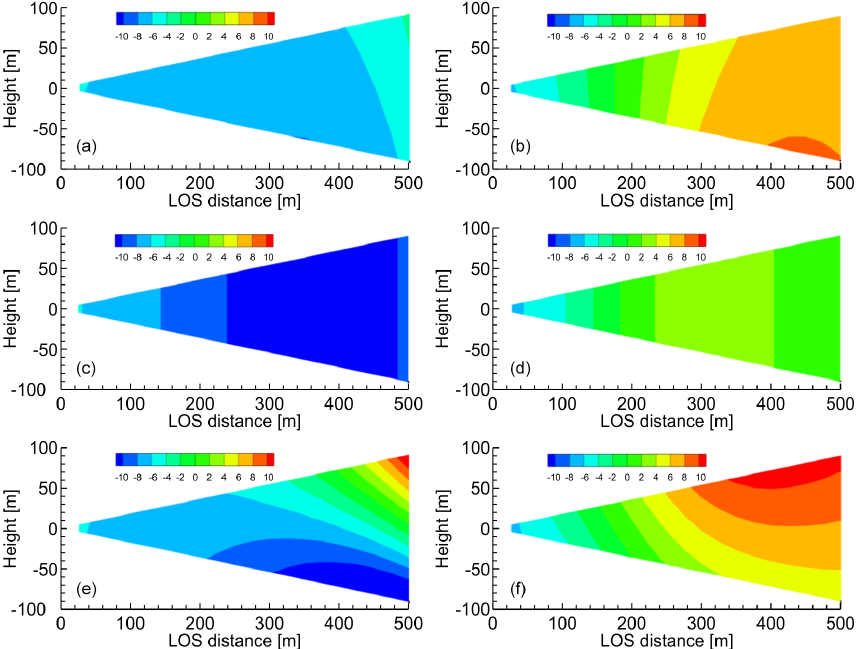
Figure 12. Distributions of the horizontal and vertical wind components estimated by the simple vector conversion method vs. the proposed method (at a time of 10s). (a, b) Ideal vortex model; (c, d) simple vector conversion method; (e, f) proposed method with five past LOS wind datasets. (a, c, e) Horizontal wind values; (b, d, f) vertical wind